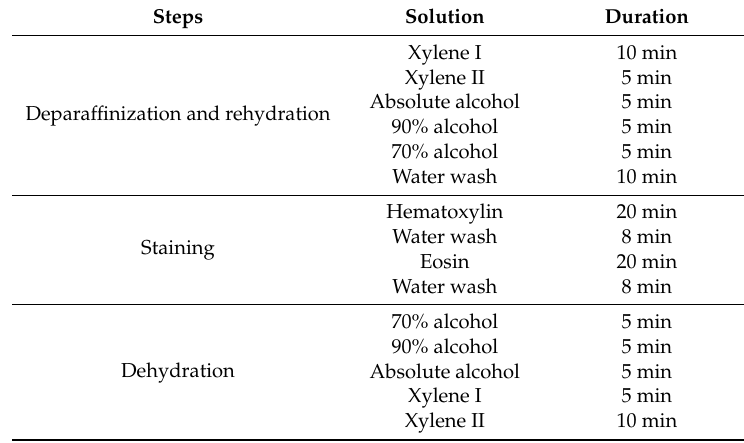
Table 2. The stages of H and E staining protocol, detailing the reagents and reaction times.